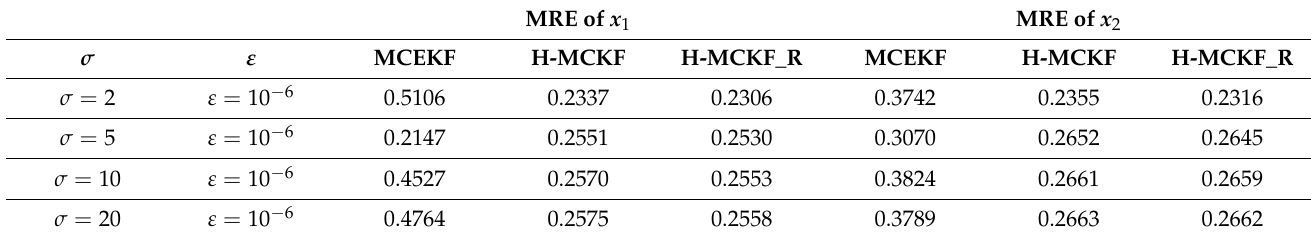
Table 4. The mean relative error using the three methods in case